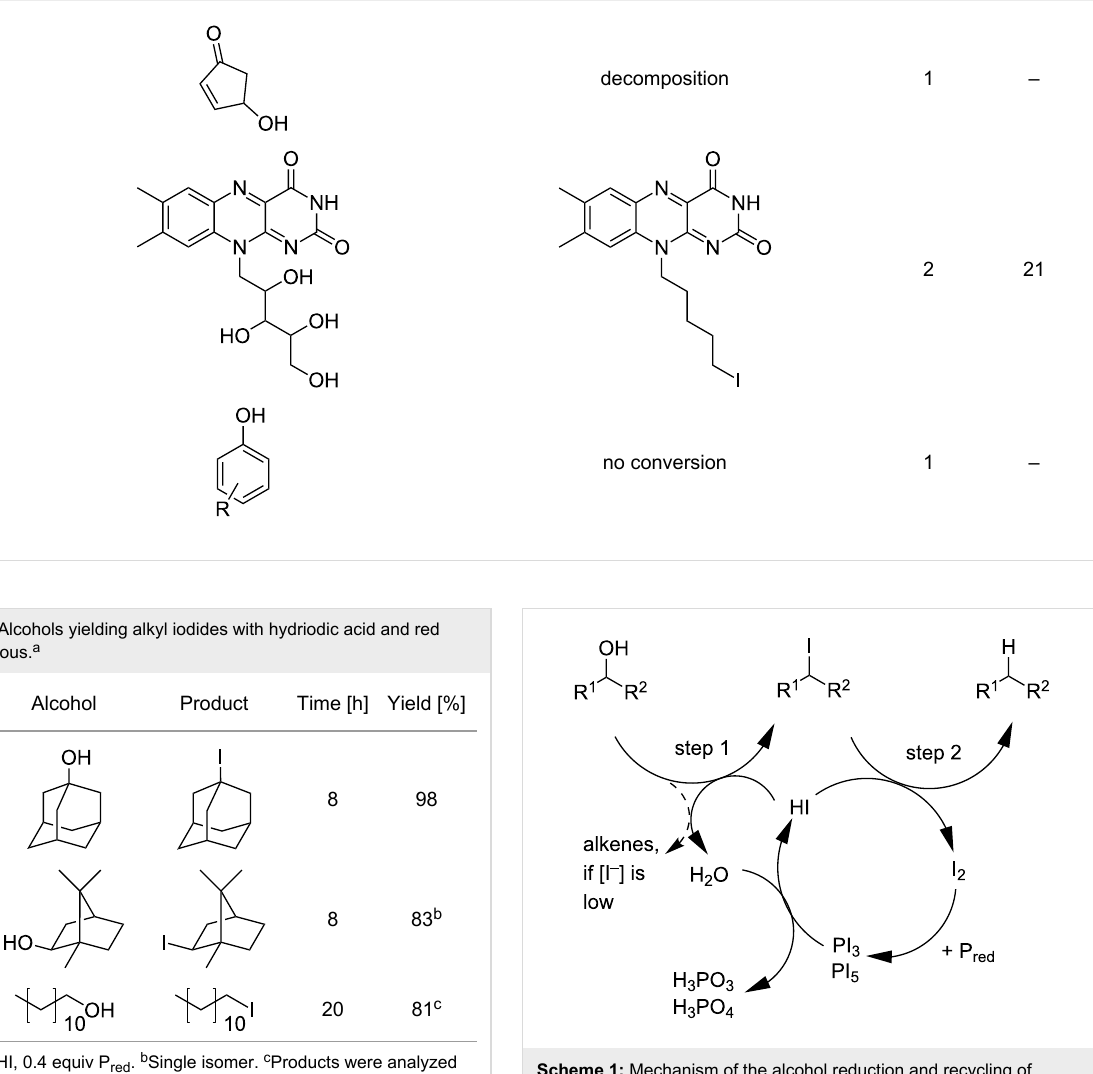
Table 2: Alcohols showing incomplete or unselective reaction with hydriodic acid and red phosphorous (3.0 equiv HI, 0.4 equiv P red ). (continued)